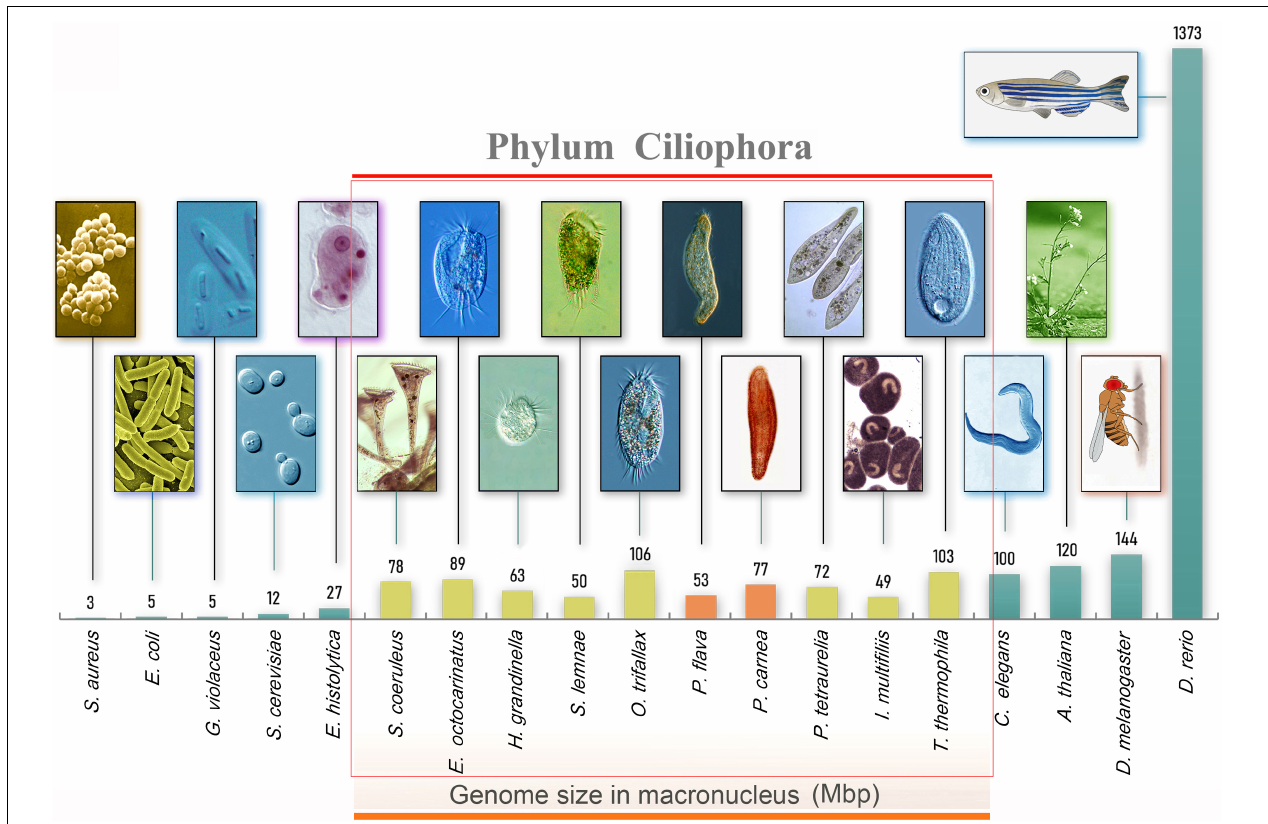
FIGURE 1 | Morphology and genome size of model organisms including ciliates. From left to right, bacteria ( Staphylococcus aureus and Escherichia coli ), cyanobacteria ( Gloeobacter violaceus ), yeast ( Saccharomyces cerevisiae ), amoeboid protists ( Entamoeba moshkovskii ), ciliated protists ( Ichthyophthirius multifiliis , Stylonychia lemnae , Oxytricha trifallax , Pseudokeronopsis flava , Halteria grandinella , Paramecium tetraurelia , Pseudokeronopsis carnea , Stentor coeruleus , Euplotes octocarinatus , Tetrahymena thermophila ), nematode ( Caenorhabditis elegans ), thale cress ( Arabidopsis thaliana ), fruit fly ( Drosophila melanogaster ), and zebrafish ( Danio rerio ).